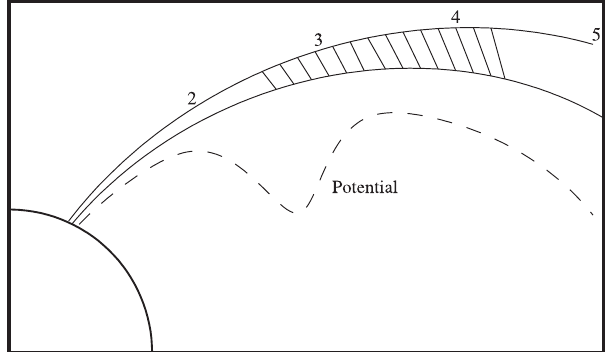
Fig. 2. Schematic picture of the SMO/randboost model geometry. An O-shaped potential whose central altitude is s O is 2 : 5 R E and half-thickness 0 : 4 R E is indicated by dashed line . Random boosts are e(cid:128)ective in the hatched altitude range. The s values (field-aligned coordinate) are shown on top . Table 1 indicates how other models di(cid:128)er from this particular